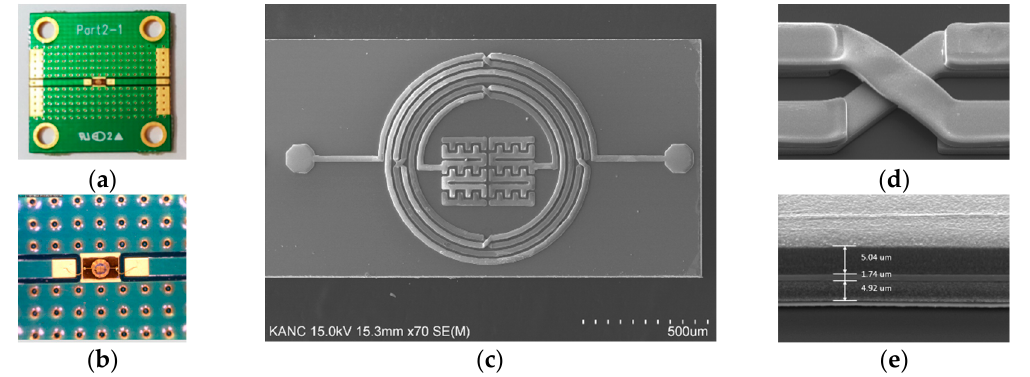
Figure 7. ( a ) Packaged BPF on the printed circuit board; ( b ) enlarged view of the wire-bonded BPF; ( c ) SEM figure of the top view of the BPF; ( d ) enlarged view of the air-bridge area; ( e ) cross-section of the device using the GaAs-based IPD technology.